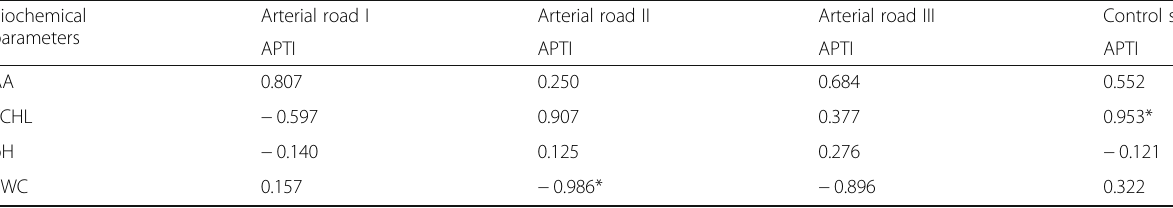
Table 10 Correlation matrix between the APTI values and some studied parameters Biochemical